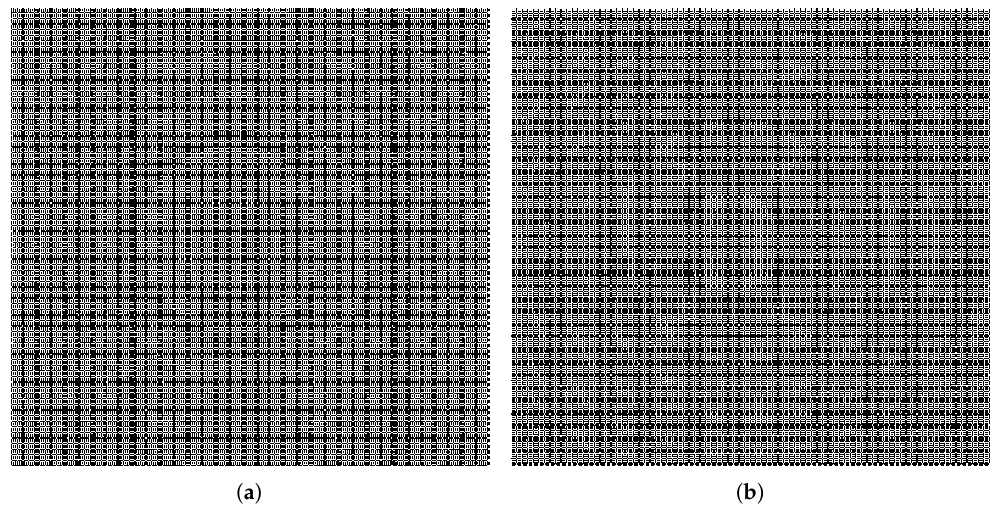
Figure 7. Layout of the designed reflectarray employing the database and the unit cell of Figure 1. ( a ) Bottom layer. ( b ) Upper layer.